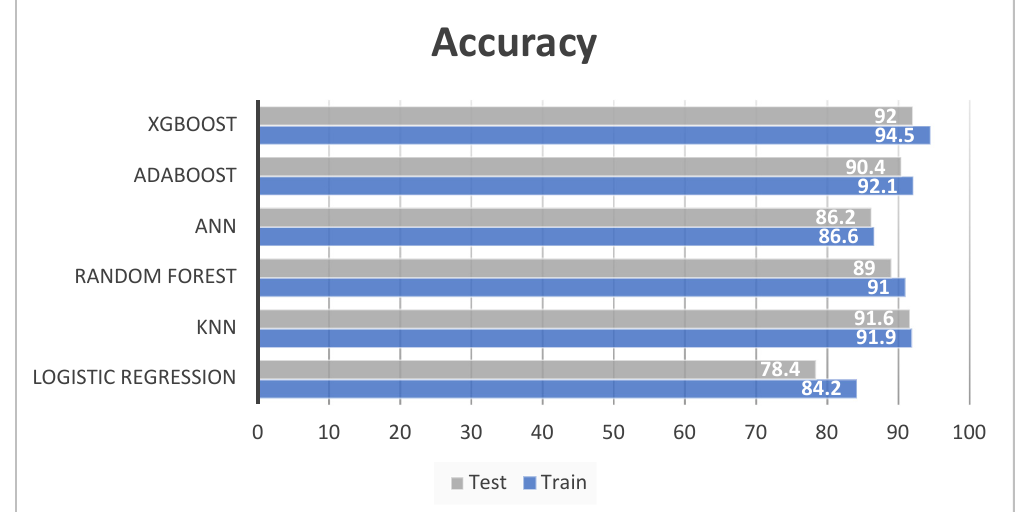
Information 2022 , 13 , 330 Figure 8. Training and testing accuracies of various classifiers. Figure 8. Training and testing accuracies of various classifiers.